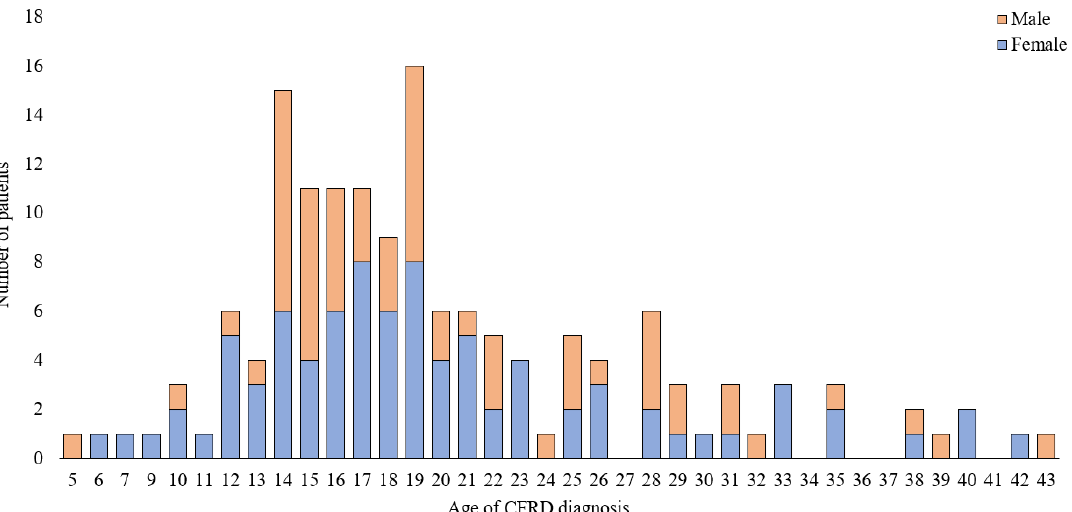
Figure 2. Age of CFRD diagnosis by sex group.